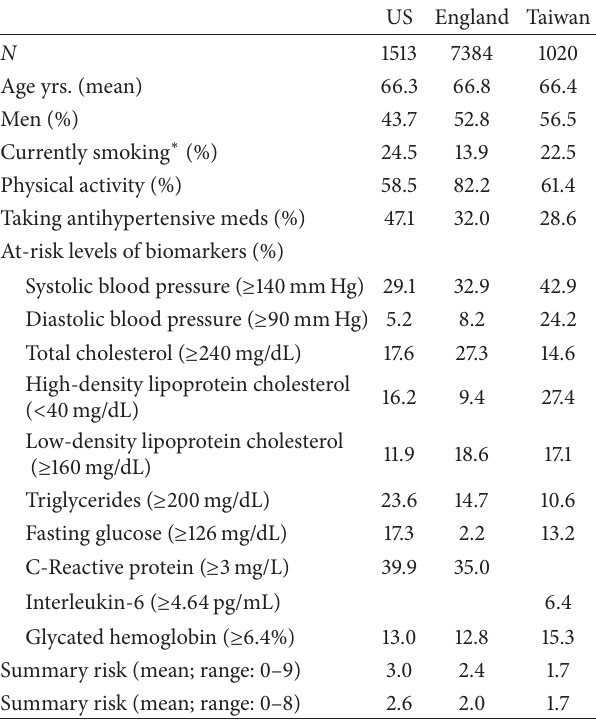
Table1: Characteristicsofpersonsaged54+intheUS,England,and